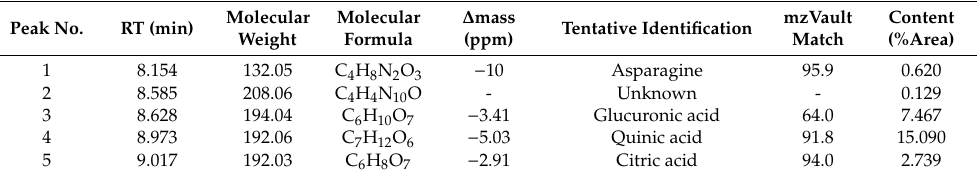
Table 3. The compounds in CFEE as identified by UHPLC-HESI-MS / MS. Peak